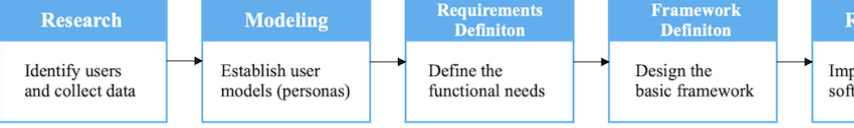
Figure 1. Workflow of the goal-directed design process.